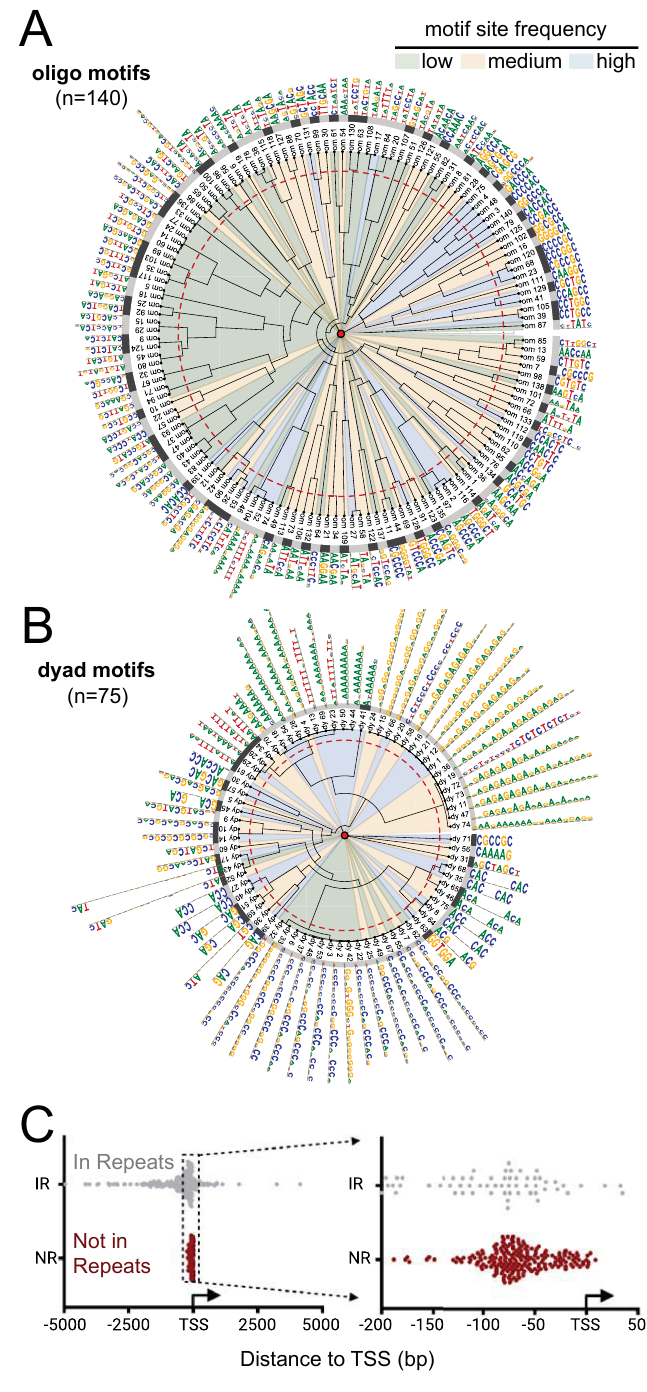
Fig 5. Global summary of maize earshot motifs discovered by MOA-seq. (A-B) Radial similarity-cluster tree of the 140 oligo (A) and 75 dyad (B) consensus motifs identified within MOA-seq footprints. Circular sectors underlying tree branches are colored to highlight the frequency at which each motif occurred (high > 2000, medium 2000–1000, low < 1000). The inner (red dash) colored ring indicates similarity threshold for motif clustering at 90% similarity, delineating different motif clusters (alternating light and dark gray ring) flanked by motif names and consensus sequence logos at the inner and outer circles, respectively. (C) Median distance to the nearest transcription start site (TSS) plotted for each motif found in regions annotated as within repeats (IR, grey) or in non-repetitive regions (NR, red).